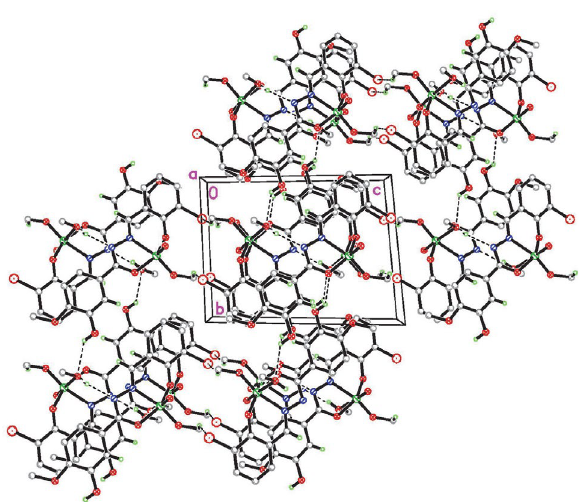
Figure 5. Crystal structure of complex 1 , with hydrogen bonds indi- cated by dotted